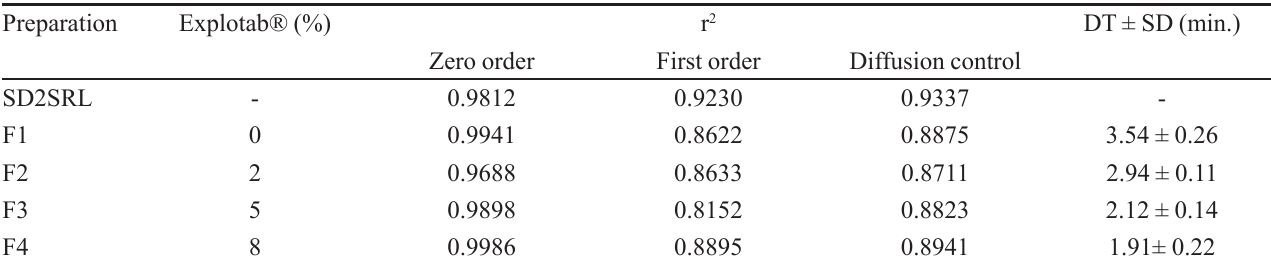
TABLE IV - Model fitting parameters and Disintegration Time of solid dispersion powder and capsules Preparation